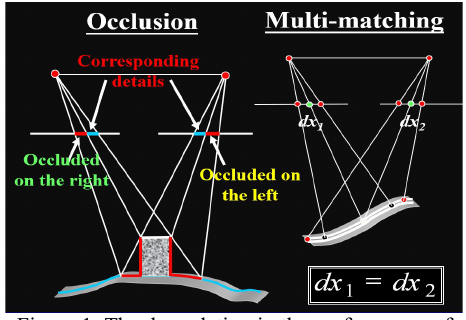
Figure 1: The degradation in the performance of